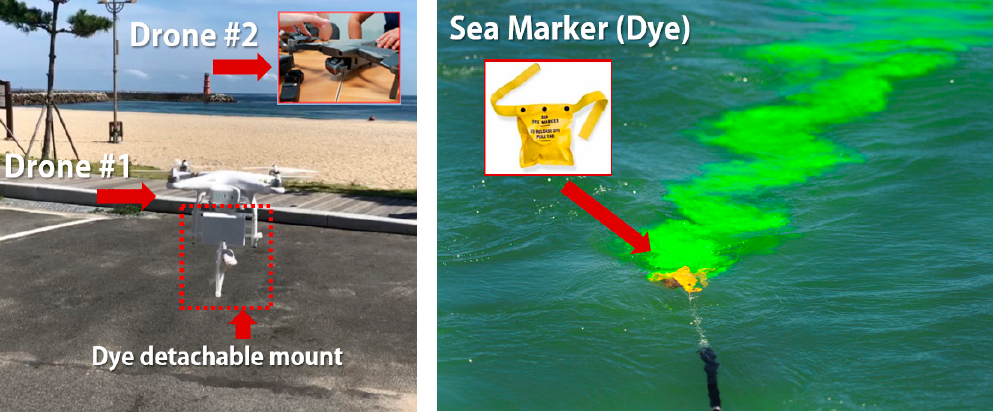
Figure 8. Drone and Sea Marker (Dye).